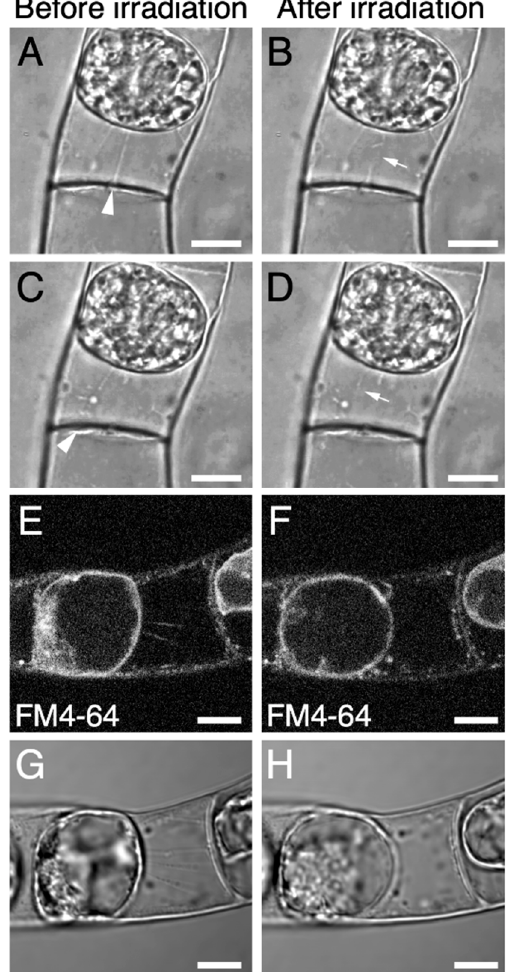
Figure 2. The destruction of Hechtian strands by femtosecond (fs) laser irradiation in plasmolyzed BY-2 cells. ( A – D ) typical images of plasmolyzed BY-2 cell before ( A , C ) and after ( B , D ) fs laser irradiation. The Hechtian strands indicated in ( A ) or ( C ) (white arrowheads) were cut in the middle of the strand by fs laser irradiation (white arrows in ( B , D )). ( E – H ) another example of plasmolyzed BY-2 cells before ( E , G ) and after ( F , H ) fs laser irradiation. Hechtian strands were labeled with FM4-64 ( E , F ). Scale bars = 10 µm.